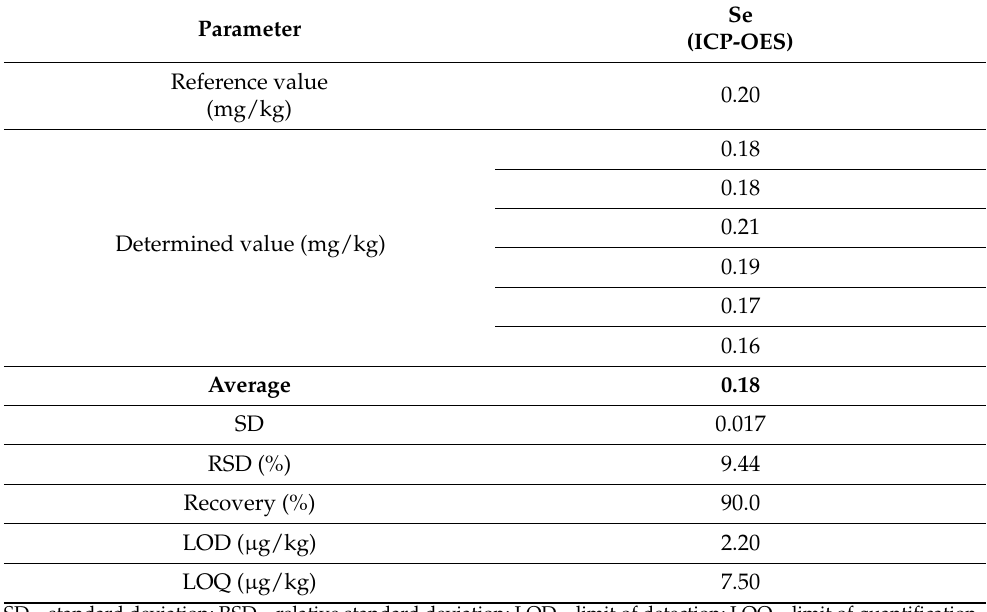
Table 2. Selective parameters of the applied analytical